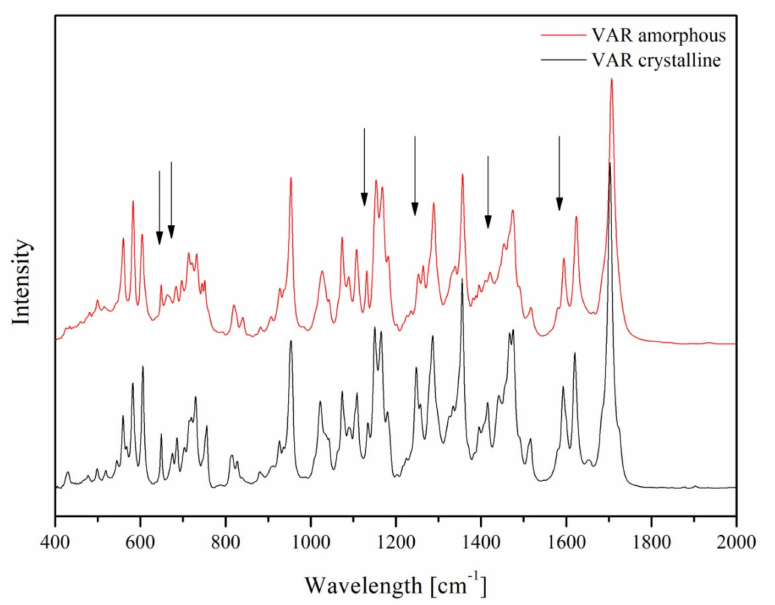
Figure 3. Fourier-transform infrared spectroscopy (FT–IR) of crystalline and amorphous form of